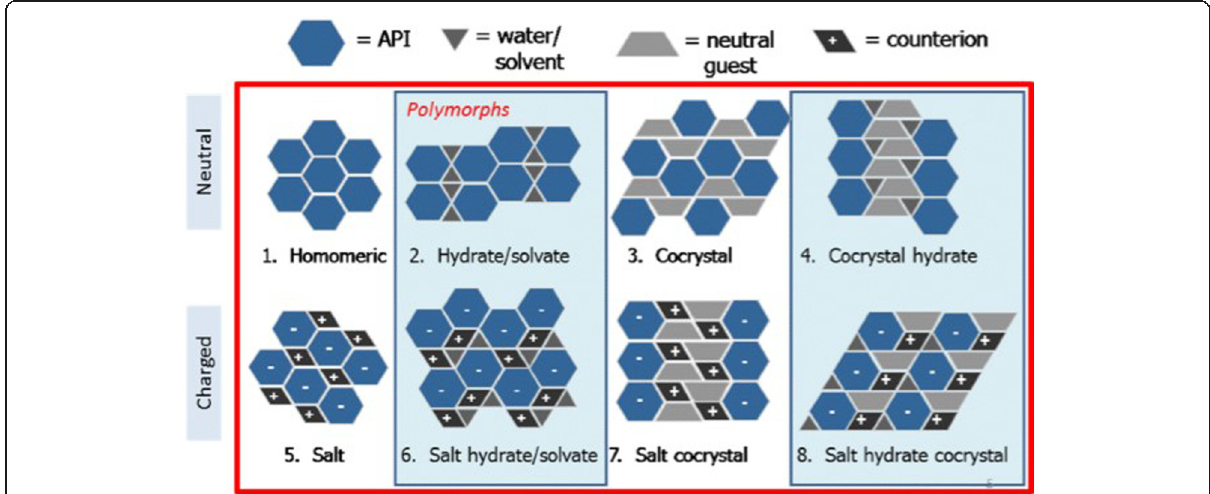
Fig. 1 Classification of crystalline API forms. The red box signifies that polymorphs of all solid form classes are possible; the blue boxes represent classes containing